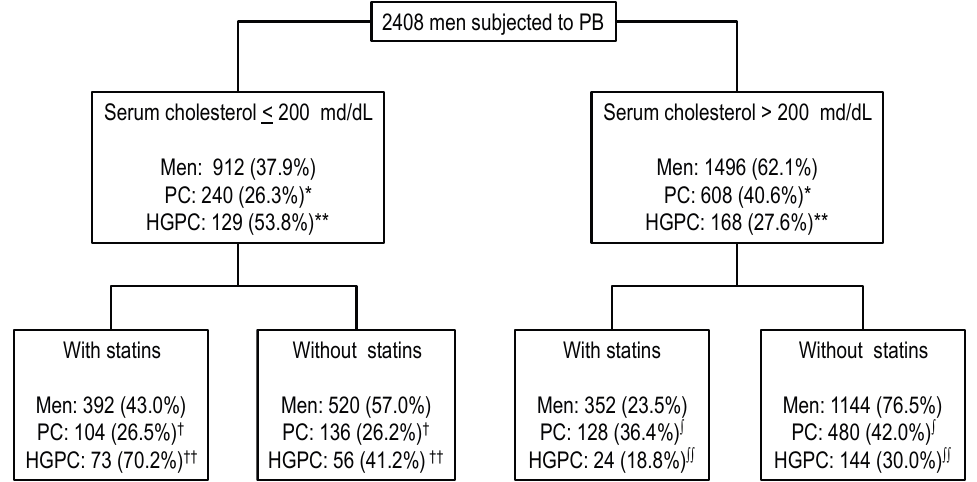
Figure 1. Risk of prostate cancer (PCa) detection and high-grade PCa detection according to the quality of serum cholesterol level and chronic statin use. PB, prostatic biopsy; * , p < 0.0001, OR: 1.917 (95% Cl 1.601–2.295); ** , p < 0.001, OR: 0.329 (95% Cl 0.241–0.448); † , p = 0.939, OR: 1.020 (95% Cl 0.757–1.373); †† , p < 0.001, OR: